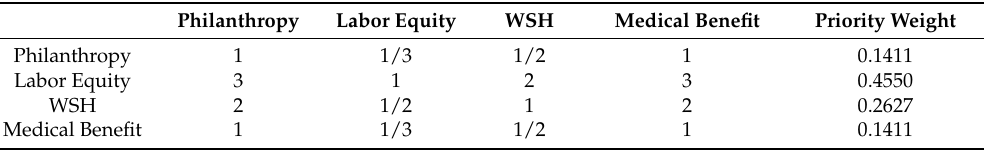
Table 6. Pairwise Comparison of Sub Criteria w.r.t. Social